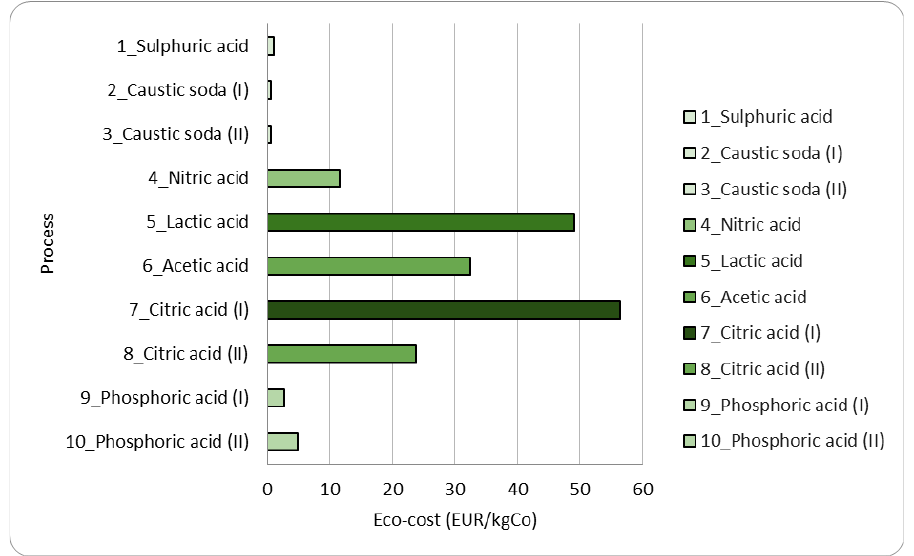
Figure 8. Eco-cost results calculated for the 10 processes reported in Table 1.